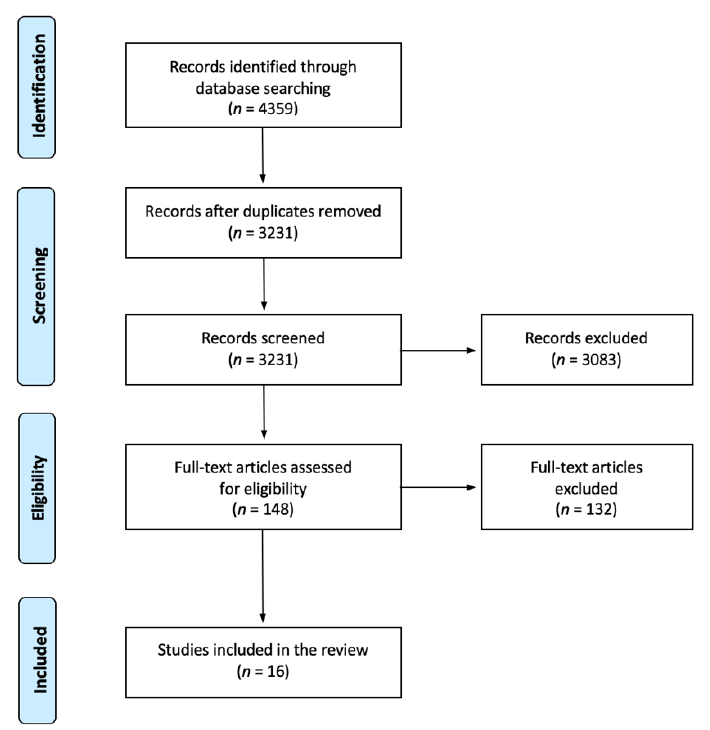
Figure 1. Flow diagram of included studies.